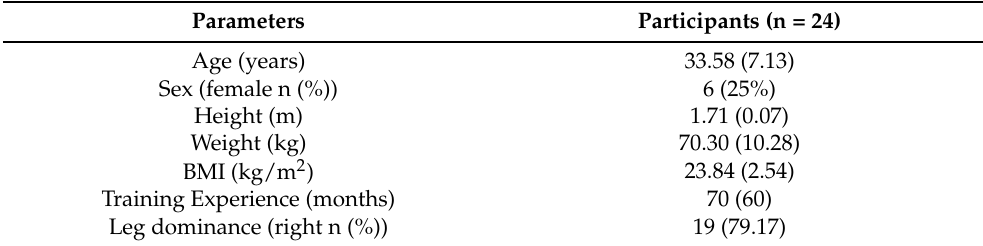
Table 1. Summary of participants’ demographics, reporting mean (standard